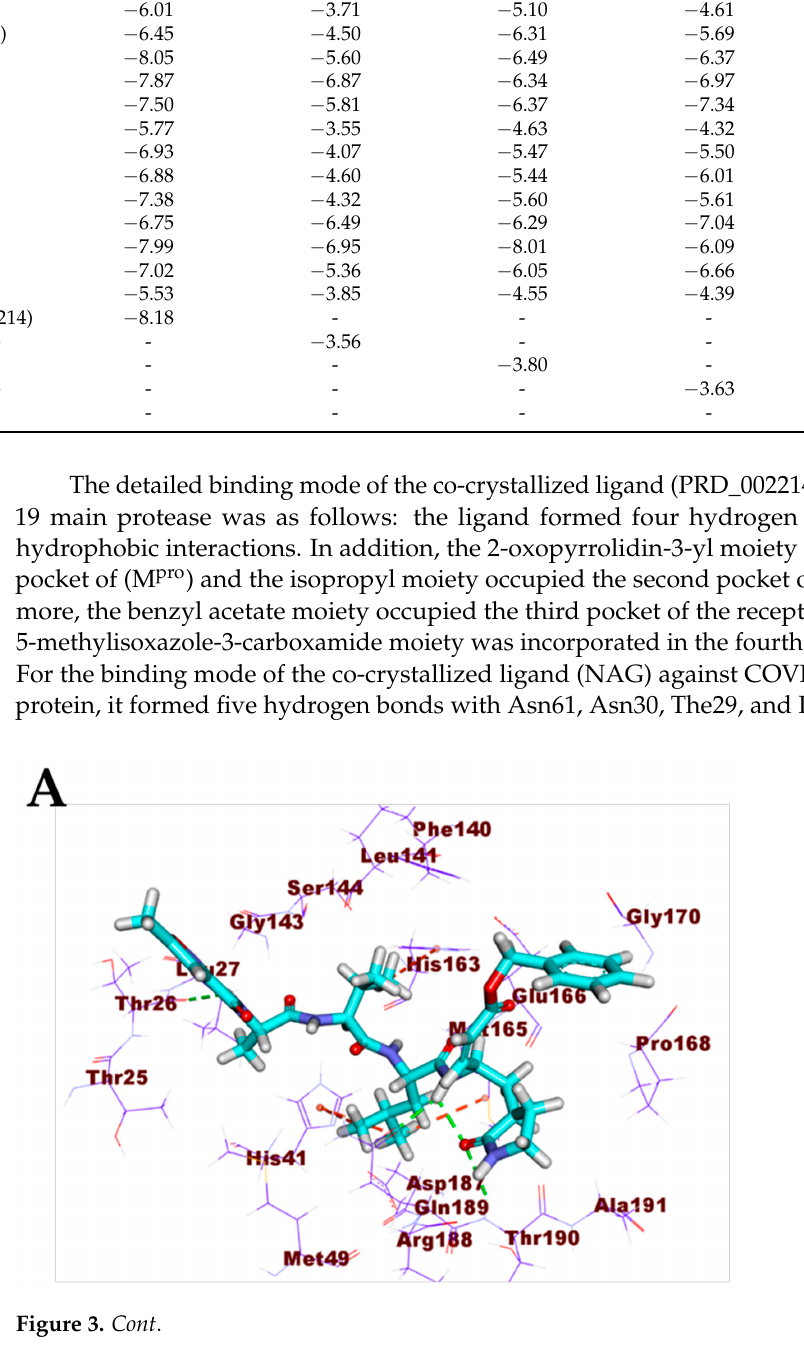
Figure 3. ( A ) Co-crystallized ligand (PRD_002214) docked into the active site of COVID-19 main protease. ( B ) Mapping surface showing co-crystallized ligand (PRD_002214) occupying the active pocket of COVID-19 main protease.